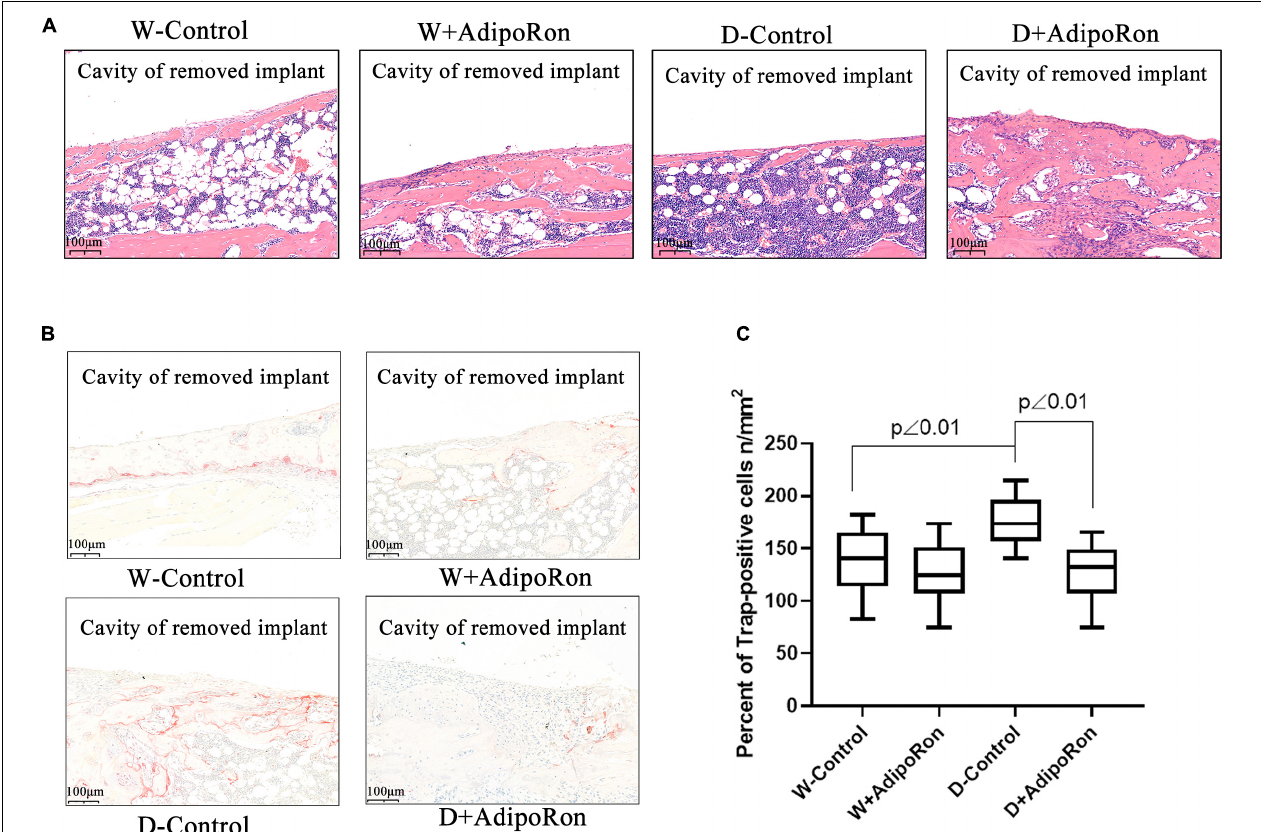
FIGURE 2 | Pathological examinations of femoral bone with dental implants in mice. Femoral bone pathology was observed. Normal mice (Wild-control, W-control), normal mice treated with AdipoRon (Wild + AdipoRon, W + AdipoRon), diabetic mice (Diabetes-control, D-control), and diabetic mice treated with (Diabetes + AdipoRon, D + AdipoRon) were involved. n = 7. (A) H&E staining of femoral bone with dental implants in mice was shown. One section in the region surrounding the explant of each sample was selected for analysis and five fields of vision were randomly selected in each section. The green arrow indicates bone hyperplasia mediated by the osteoblast differentiation. (B) TRAP staining of femoral bone with dental implants in mice is shown. The blue arrow indicates the osteoclast formation. (C) TRAP-positive cells of osteoclast were analyzed.